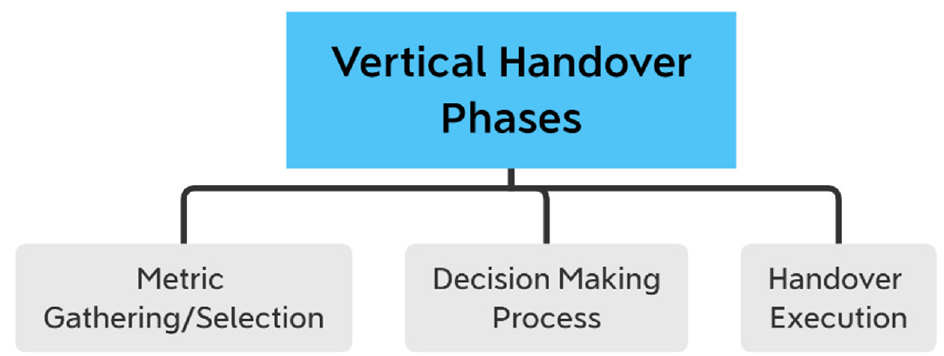
Figure 1. The structure of VHO. Hybrid networks have the potential to raise network performance, though when user mobility is factored into the equation, load balancing (LB) concerns and the consideration of correct HO decisions become more difficult and complex. This is because the WiFi AP typically has a lower capacity than the LiFi AP [15] but a wider coverage area. To prevent inter-cell interference in a homogeneous network, the overlapped coverage among LiFi strength strategy (SSS), which places every user with the AP that has the strongest received signal strength, is frequently utilized in homogeneous networks. As a result, if the SSS approach is employed, a WiFi AP would be able to serve more users than a LiFi AP.